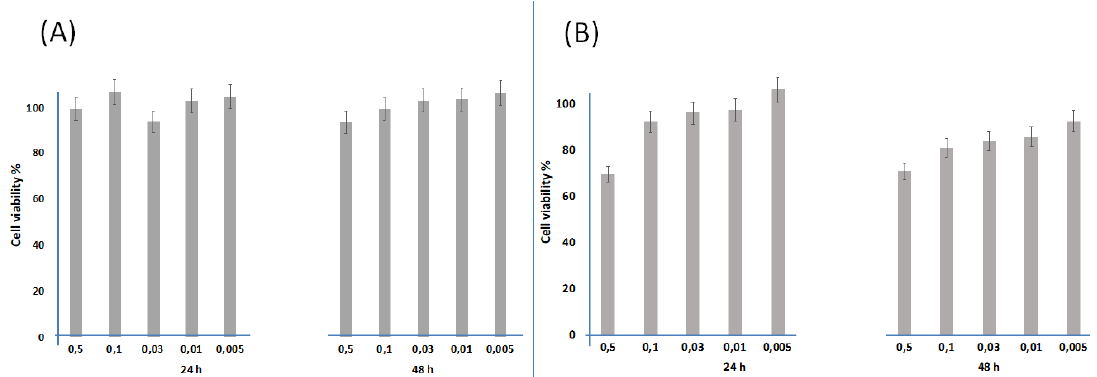
Figure 14. Cell viability % (tetrazolium salt (MTS) assay) of poly-6-MOEG-9-T- BF3k -FE on human colon cancer cells HCT116 (panel A ) and normal human bronchial epithelial cells 16HBE (panel B ) cells, after 24 h and 48 h of incubation at concentrations of 0.005, 0.01, 0.03, 0.1 and 0.5 mg/mL.